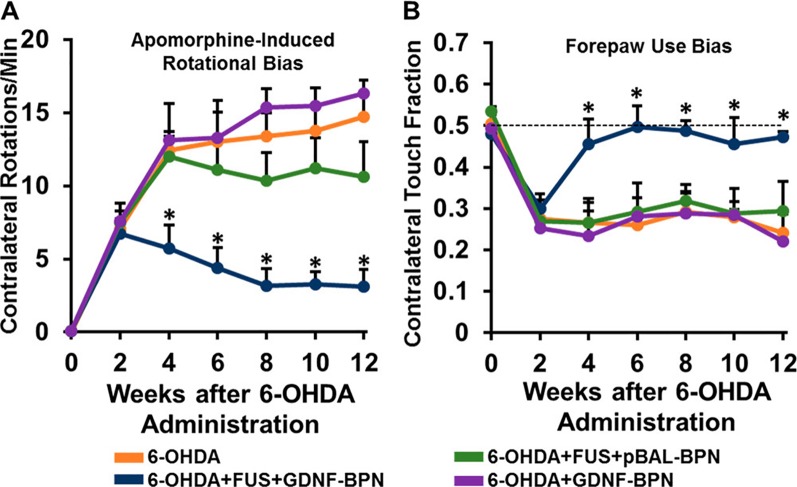
Delivery of glial cell-derived neurotrophic factor gene-bearing nanoparticles (GDNF-BPN) with FUS restores locomotor function in PD rats. (A) Line graph of average contralateral rotations per minute after apomorphine administration. (B) Line graph of contralateral touch fraction in the forepaw use bias test. n > 14 in each group at weeks 0 through 6; n > 7 in each group at weeks 8 through 12. *Significantly different than all other groups at the same time point (p < 0.01).Adapted from Mead et al. (2017). Reproduced with permission.